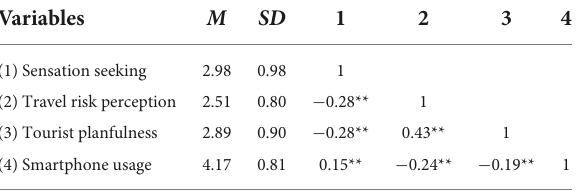
TABLE 1 Means, standard deviations, and zero-order correlations among study